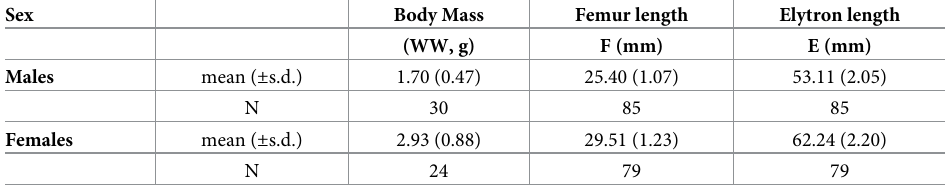
Table 1. Morphometrics (mm) and body mass (WW, g) for desert locusts collected at the study site on 27 October and 10 November 2005.